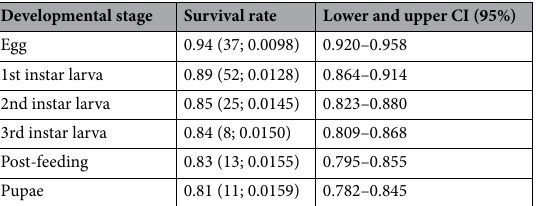
Table 1. Survival rates for all developmental stages of T. rugosus at six constant temperatures. The number of deaths followed by standard error shown in parentheses ( N; SE